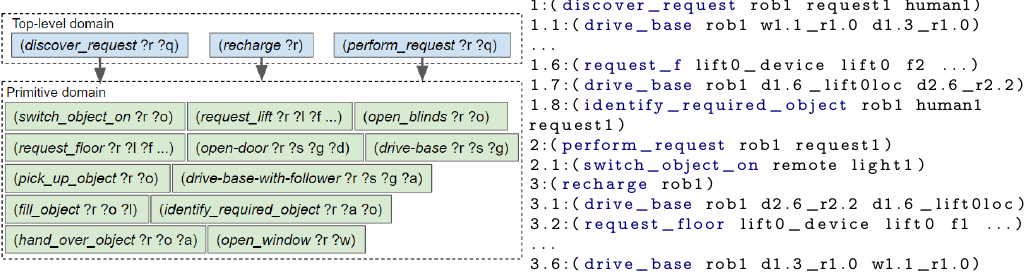
Figure 7. Action definitions split-up into two domain files; and executed actions when the state and actions are split up by key concepts.